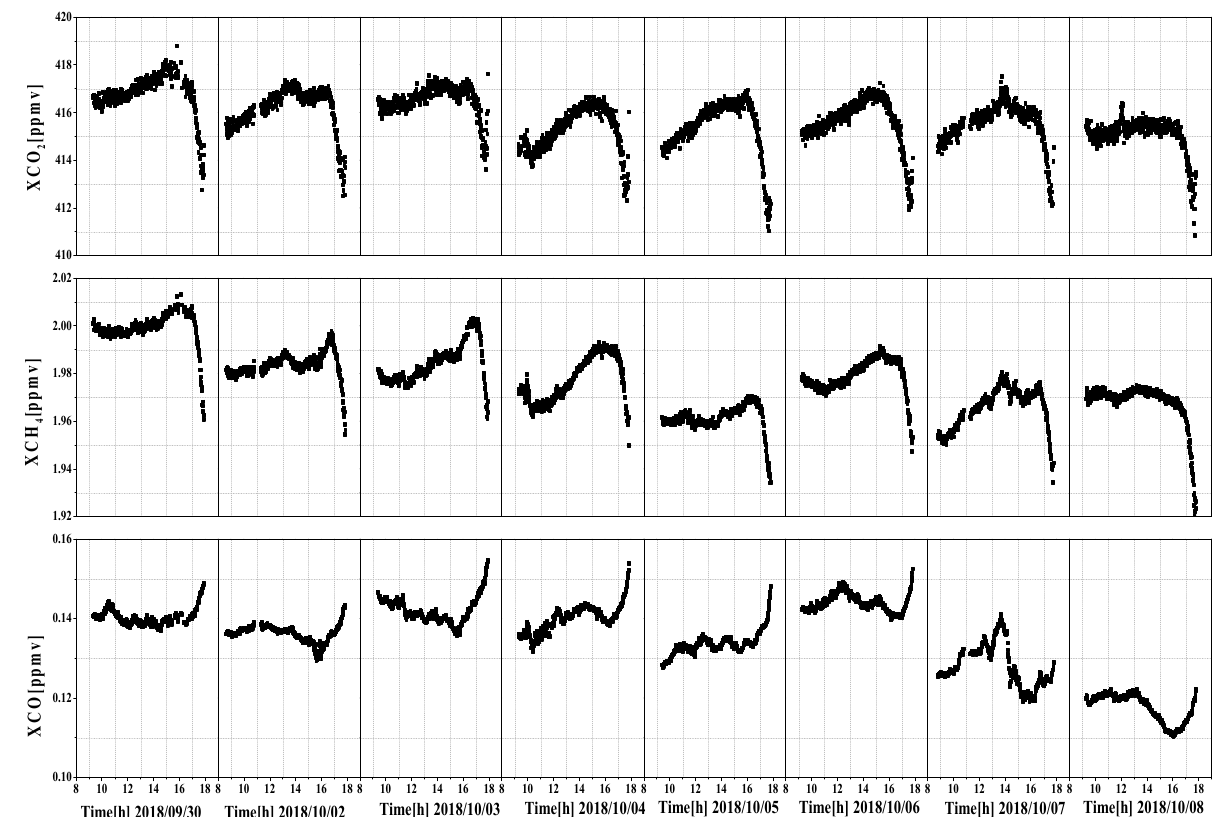
Figure 6. The four plots show the diurnal variation of XCO 2 , XCH 4, and XCO from 30 September 2018 to 8 October 2018.